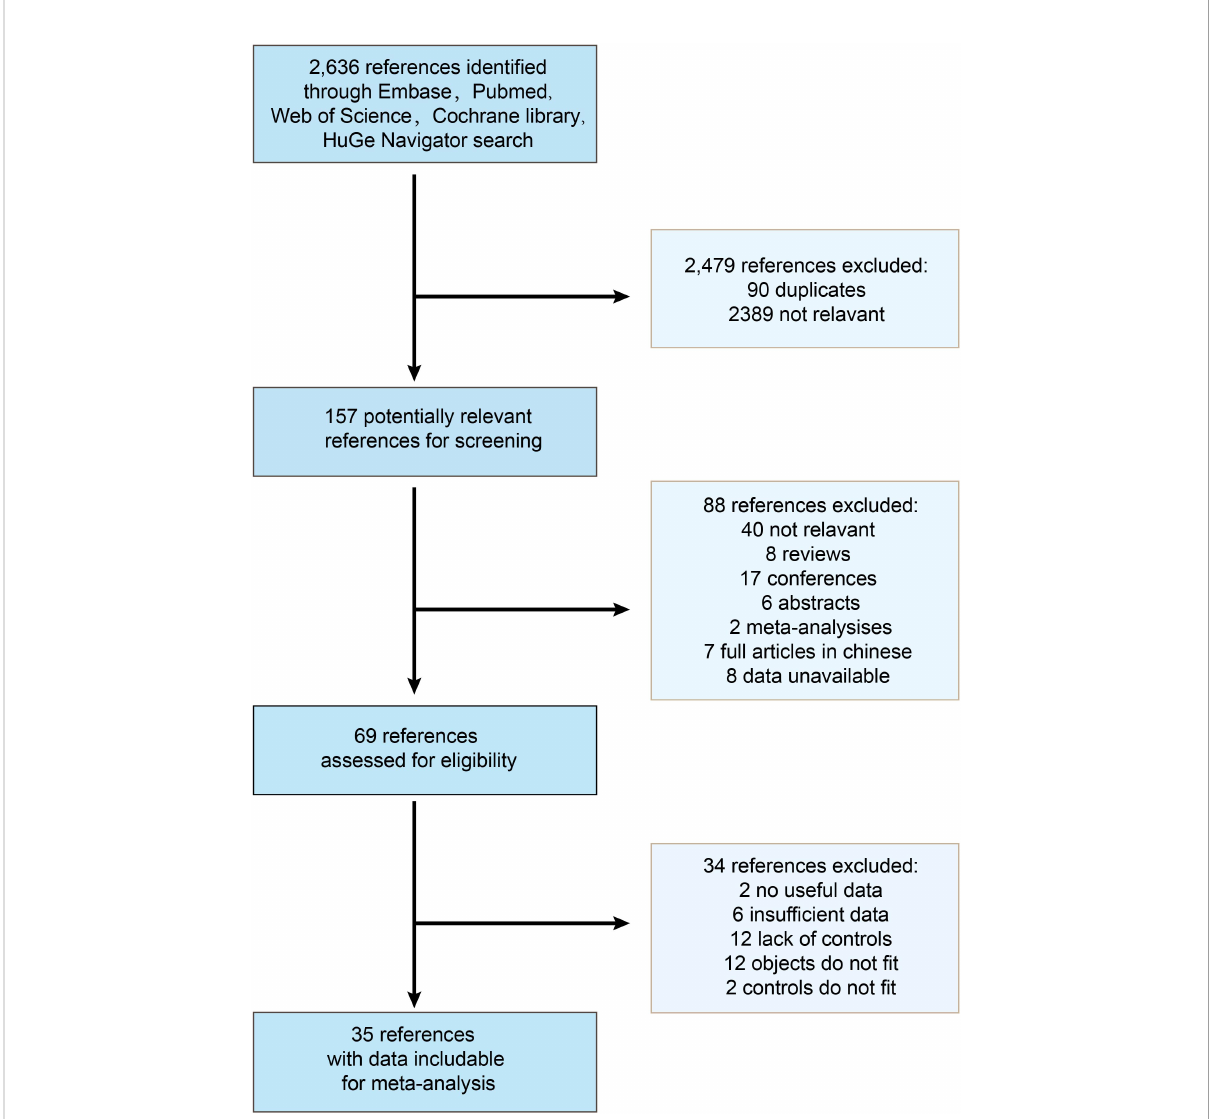
FIGURE 1 Flow chart of the study selection process. 35 studies were determined to be eligible for inclusion in the